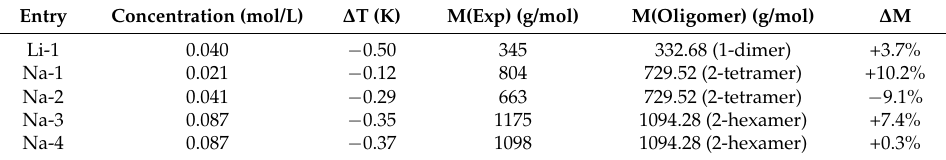
Table 1. Results of cryoscopic measurements of compounds 1 and 2 in cyclohexane. M( 1 -monomer) 166.34 g/mol; M( 1 -dimer) 332.68 g/mol; M( 2 -monomer) 182.39 g/mol; M( 2 -dimer) 364.76 g/mol; M( 2 -tetramer) 729.52 g/mol; M( 2 -hexamer) 1094.28 g/mol. Values of ∆ T [K] are relative to the melting